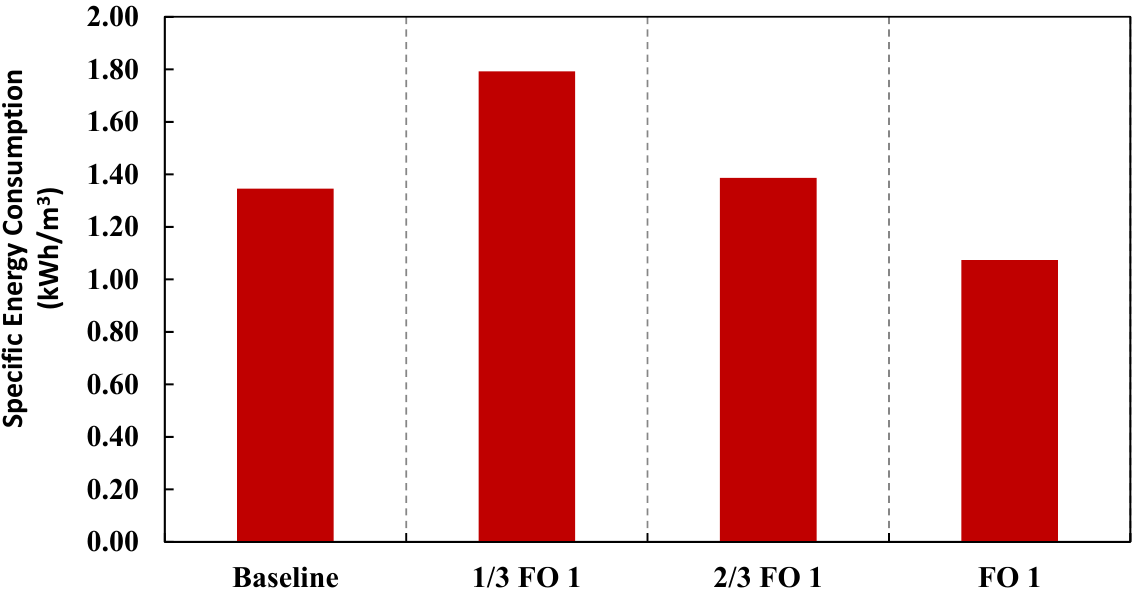
Figure 13. Specific Energy Consumption of the various capacities of the water reuse plant expressed in the conventional way in terms of unit volume of product water if water reuse plants were reduced by 1/3 and 2/3, labeled as 1/3 FO 1 and 2/3 FO 1, respectively.